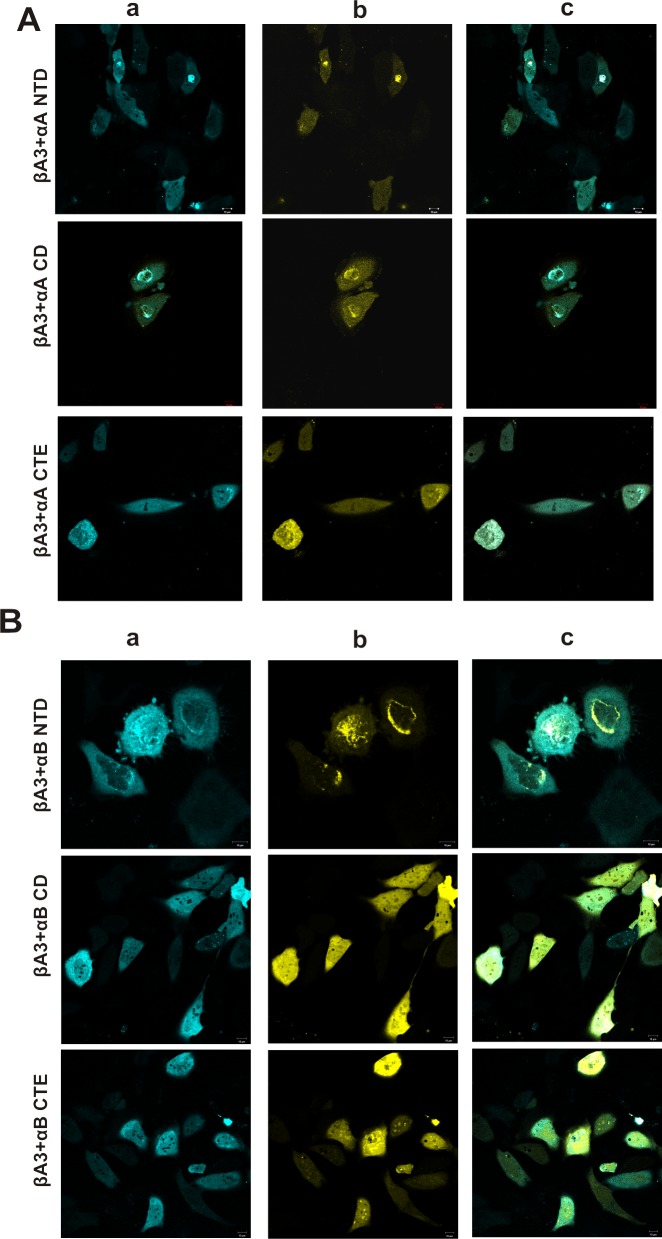
Confocal images of expression of domains of αA- and αB-crystallins with βA3-crystallin in HeLa cells.Confocal microscopic images of HeLa cells co-transfected with: A. CFP βA3-crystallin -YFP αA NTD, YFP αA CD and YFP αA CTE crystallin. B. CFP βA3-crystallin-YFP αB NTD, YFP αB CD and YFP αB CTE crystalline. Note the co-expression of CFP- and YFP-tagged crystallins.Panel a: CFP channel image of cells co-transfected with pairs of CFP- and YFP-fusion crystallins. Panel b: YFP channel image of cells co-transfected with pairs of CFP- and YFP-fusion crystallins. Panel c: Merged images for CFP- and YFP-channels of cells co-transfected with pairs of CFP- and YFP-fusion crystallins.